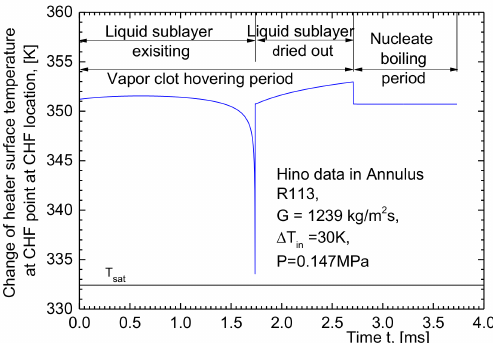
Figure 9. Calculated heater surface temperature change at channel exit (CHF occurrence